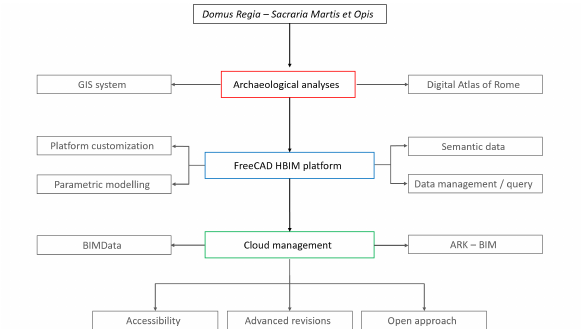
Figure 1 . Main steps related to the project workflow: